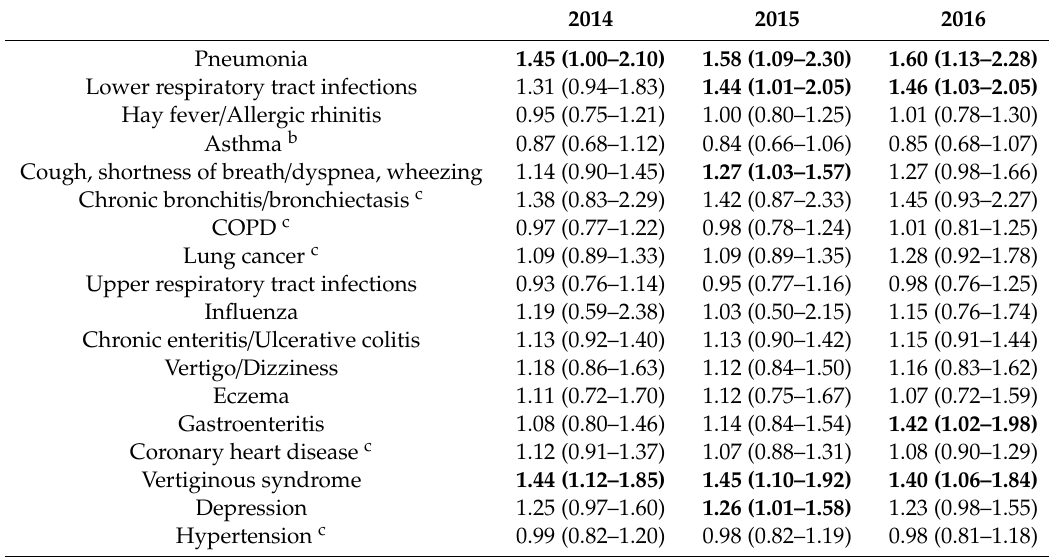
Table 1. Di ff erences (OR, 99% CI) a per year in various acute and chronic conditions between the study and control areas, based on the total sample (statistically significant results in bold)